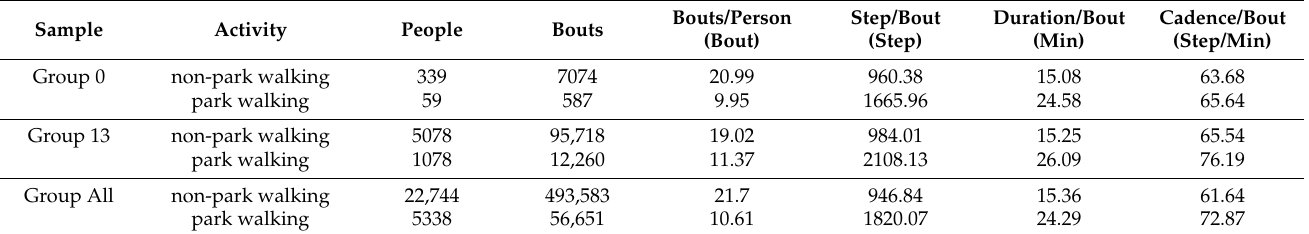
Table 2. Comparing average measures of sample groups’ park walking and non-park walking.